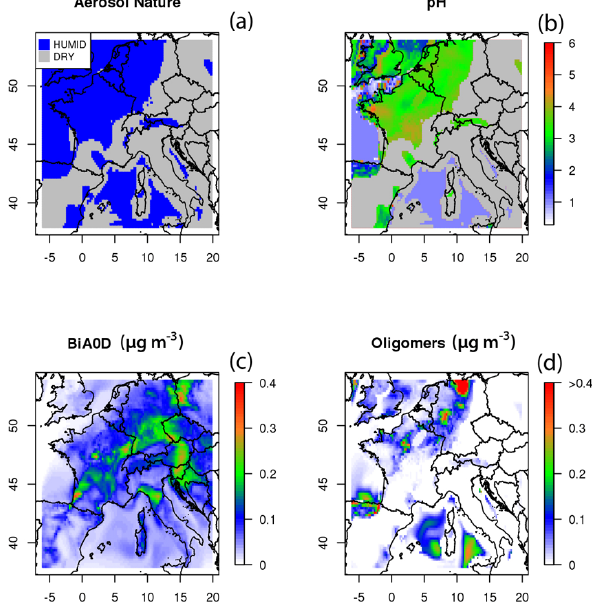
Figure 6. CHIMERE results for 24 July 2006 at 05:00UTC: nature (humid or dry) of the aerosol (a) , pH of the aqueous phase (b) ; BiA0D precursor concentration fields in the gas phase for the reference simulation (µgm − 3 ) (c) and oligomer concentrations (µgm − 3 ) (d) obtained with the KPH